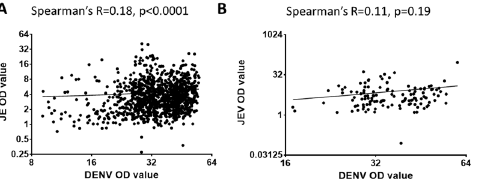
Fig 4. Association of JEV antibody optic density (OD) values with DENV antibody OD values. 4A: Correlation of JEV IgG antibody OD values and DENV IgG OD values in individuals who had mild/ asymptomatic dengue. 4B: Correlation of JEV IgG antibody OD values and DENV IgG OD values in individuals who were hospitalized due to